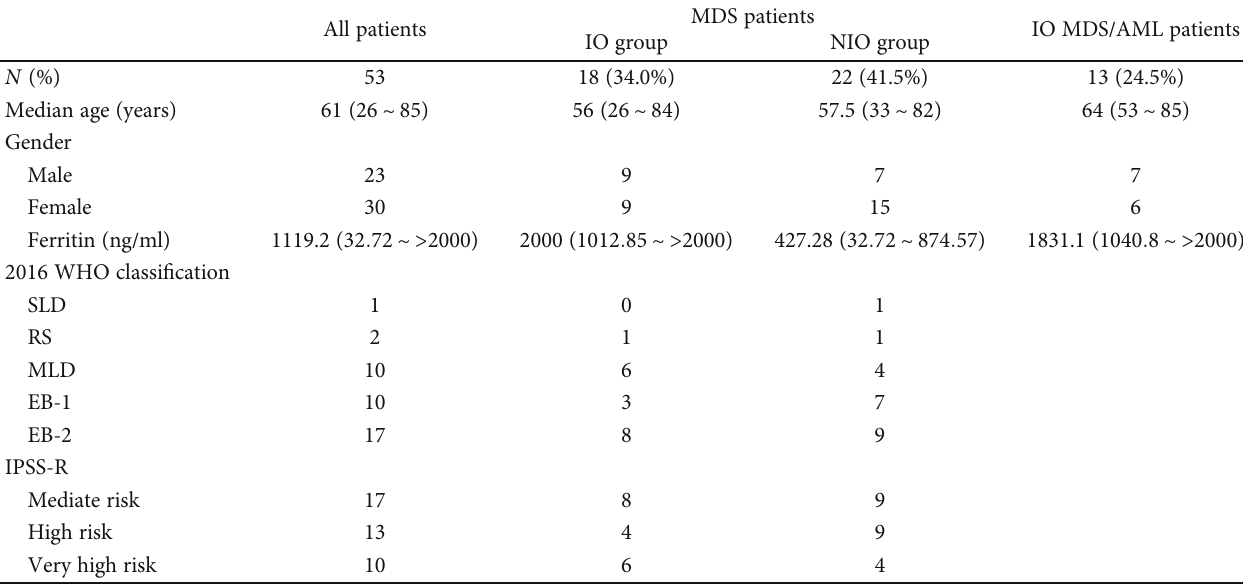
Table 1: Characteristics of